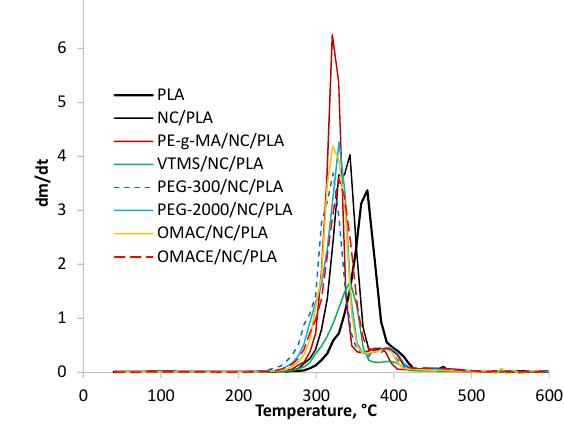
Figure 7. The weight loss and dt/dm curves of samples.